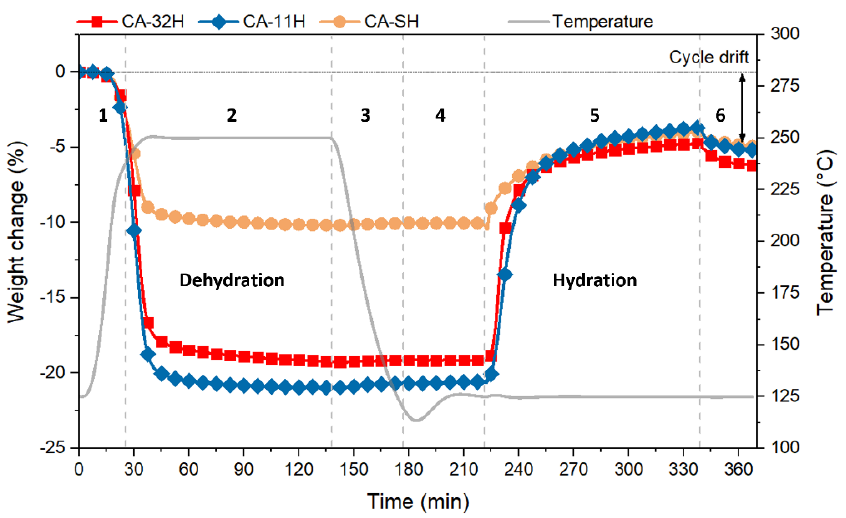
Figure 8. First dehydration/hydration cycle for CA-32H (red), CA-11H (blue) and CA-SH